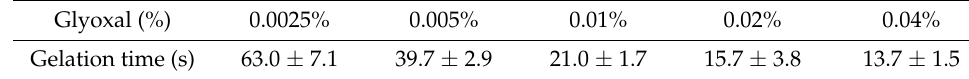
Table 1. Gelation time of CS-GE hydrogel crosslinked with different glyoxal concentrations.